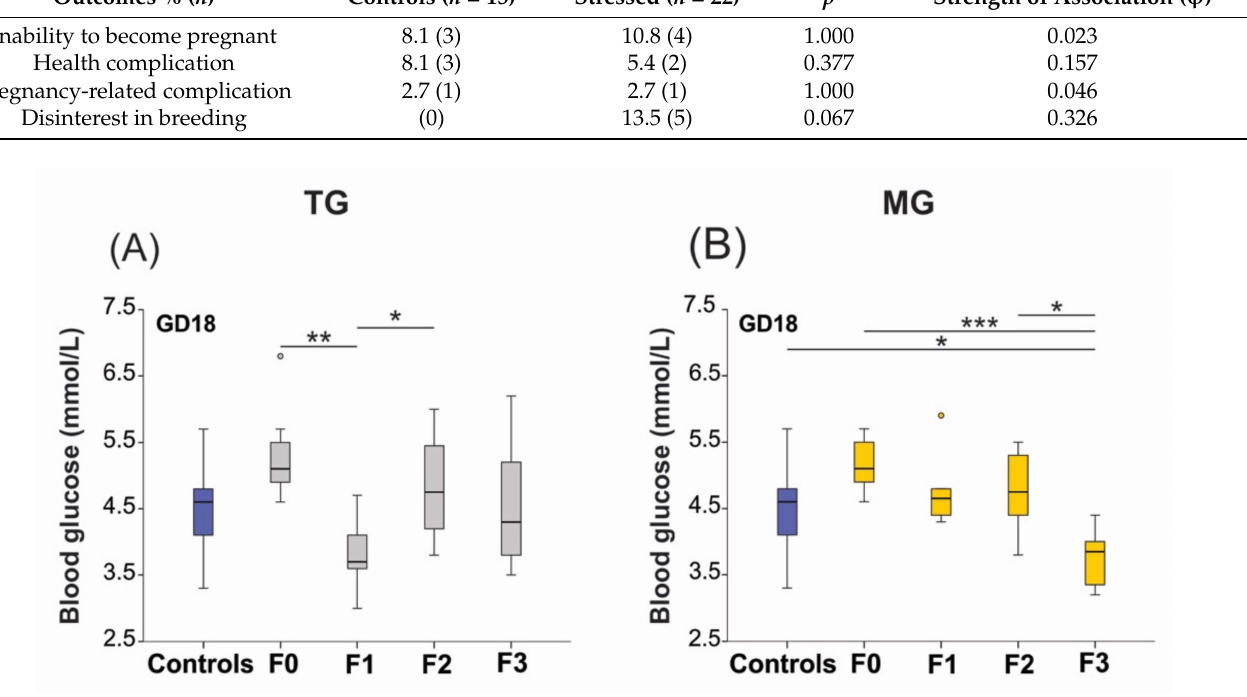
Figure 3. Blood glucose levels decreased on GD18 in the offspring of animals exposed to social isolation prenatal stress. ( A ) Blood glucose levels significantly decreased in F1 animals of the TG group ( A ) and the F3 generation of the MG group ( B ) on GD18. Asterisks indicate significance: * p < 0.05; ** p < 0.01; *** p < 0.001. Controls n = 20–28; F0 n = 10–11; F1 n = 6–8, F2 n = 10–12; F3 n = 8–11. Box plots mid-lines indicate medians, whiskers indicate min-max values, and boxes indicate interquartile